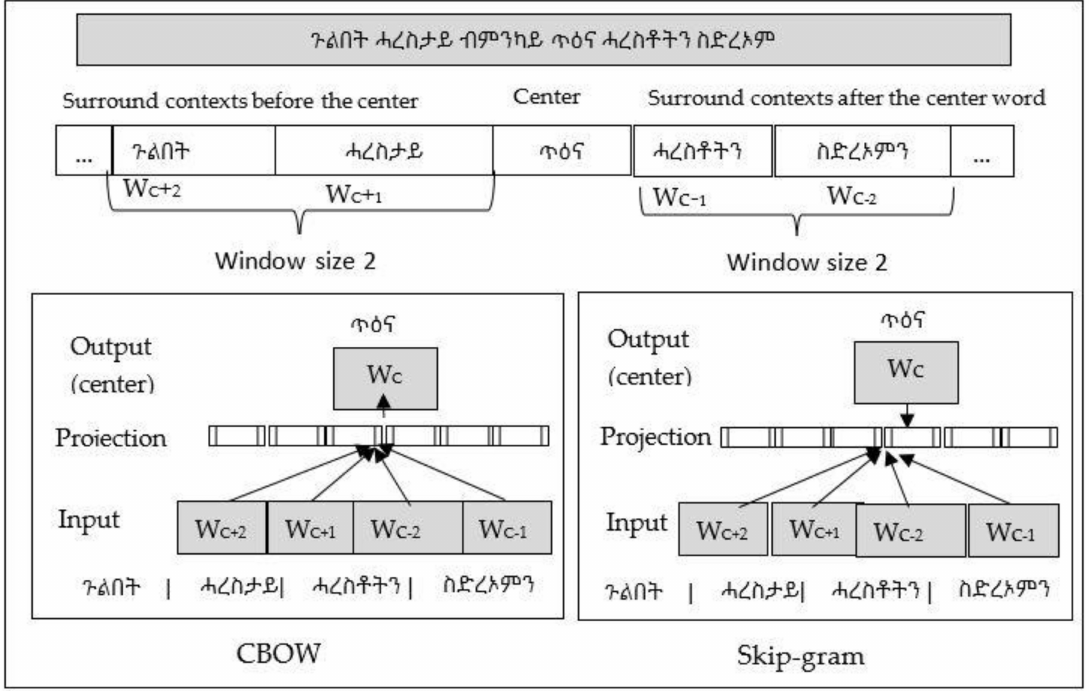
Figure 1. Continuous bag-of-words (CBOW) and skip-gram